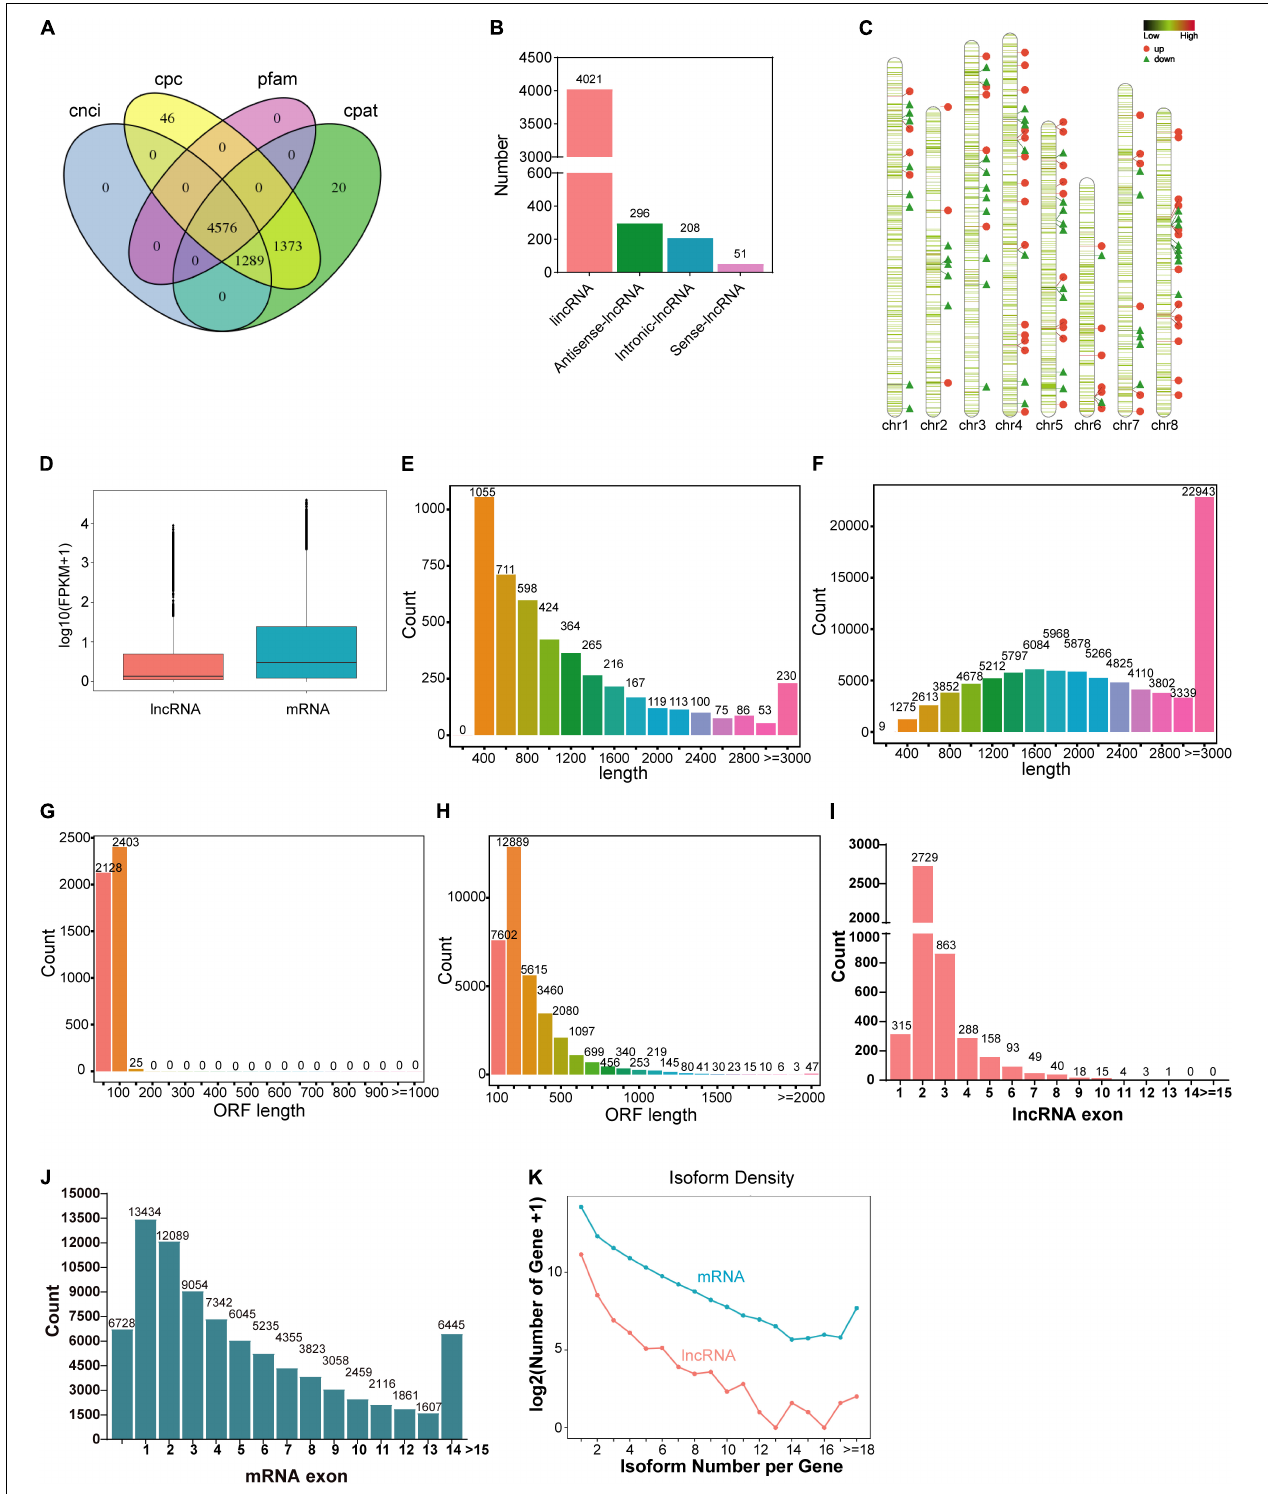
FIGURE 2 | Global identification and characterizations of lncRNAs. (A) Prediction of lncRNAs by CPC, CNCI, Pfam, and CPAT. (B) The classification of lncRNAs. (C) Chromosome distribution of lncRNAs and DElncRNAs. The green horizontal lines represent lncRNAs, the red dots represent up-regulated DElncRNAs and the green triangles represent down-regulated DElncRNAs. (D) The expression level of lncRNA and mRNA. (E,F) The length of lncRNAs and mRNAs. (G,H) The length of ORF for lncRNAs and mRNAs. (I,J) Exon number of lncRNAs and mRNAs. (K) Isoform number of lncRNAs and mRNAs.